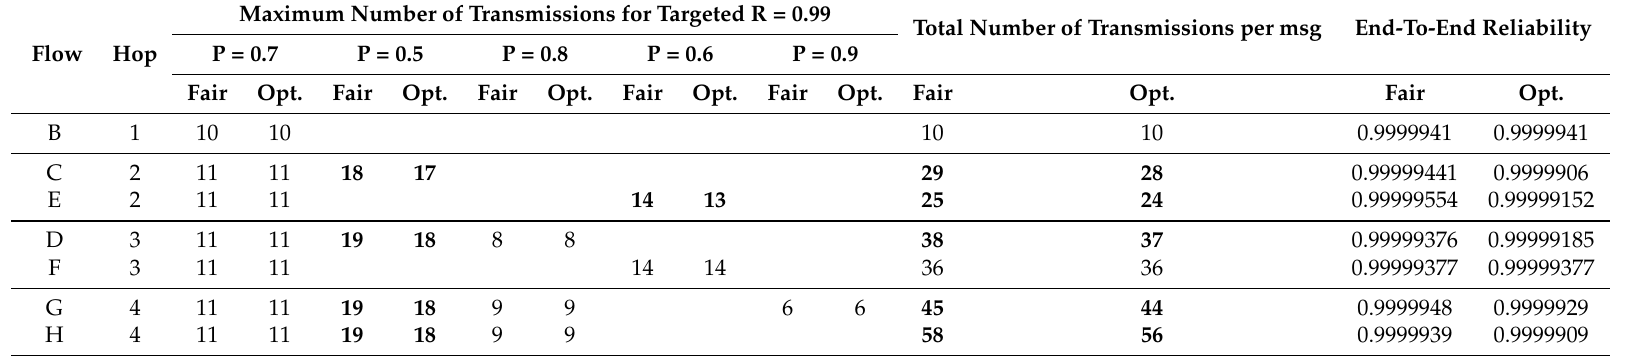
Table 7. Comparison of MFair and MOpt for a targeted end-to-end reliability R = 0.99999 on seven flows. Maximum Number of Transmissions for Targeted R =